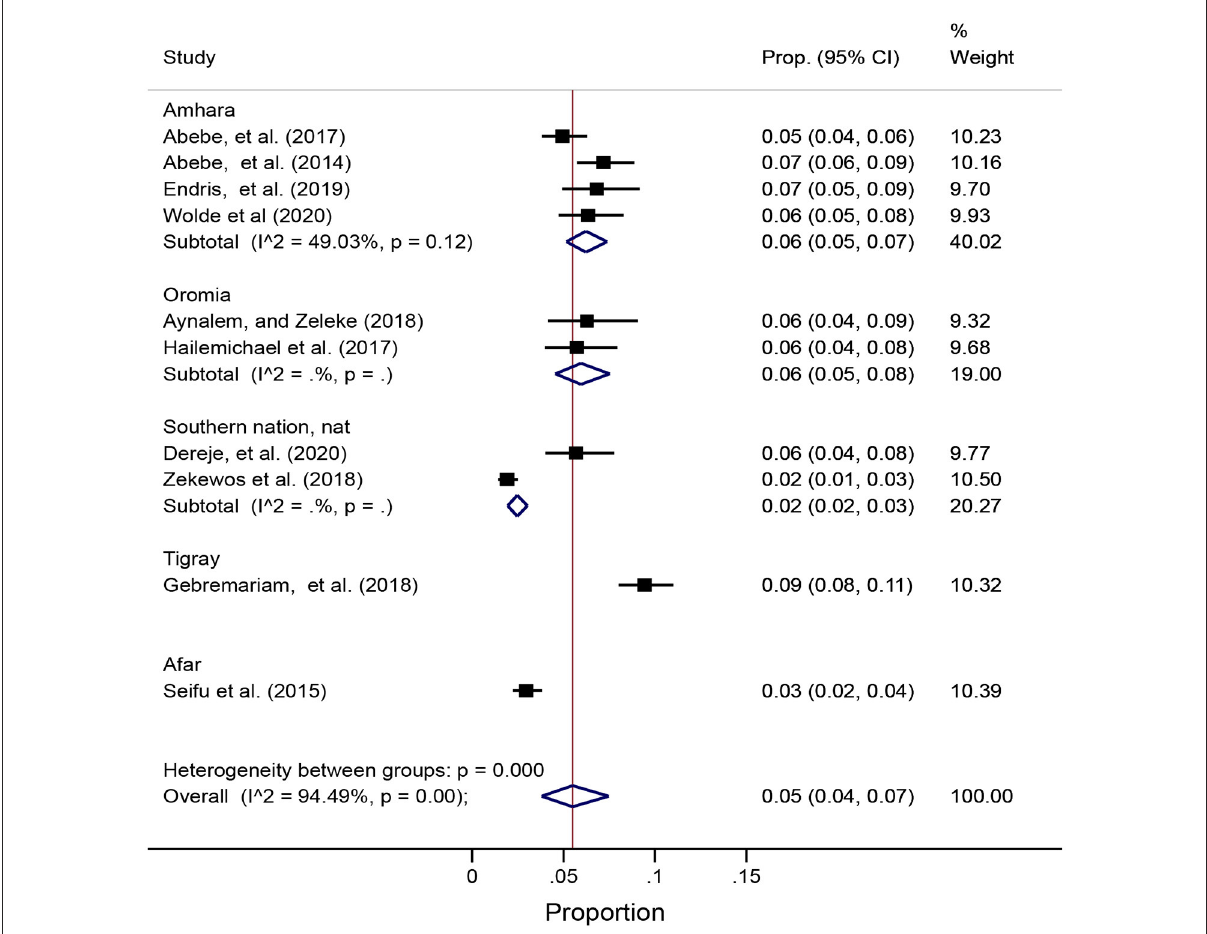
FIGURE2 Forest plot of pooled prevalence of diabetes mellitus overall and by regional states in Ethiopia using the random effect